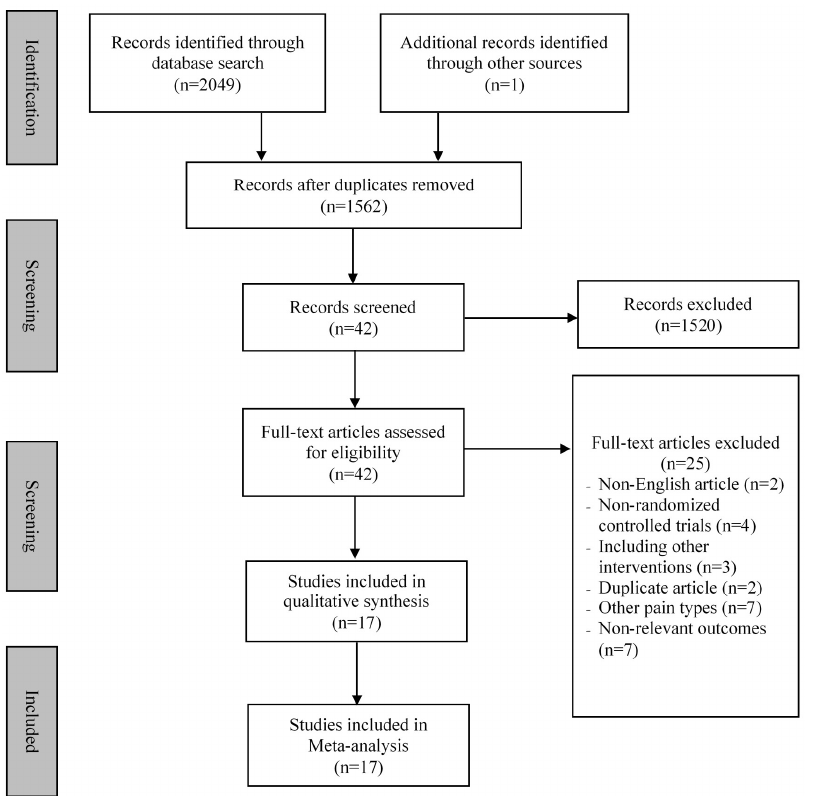
Figure 1. Flow chart of study searching.